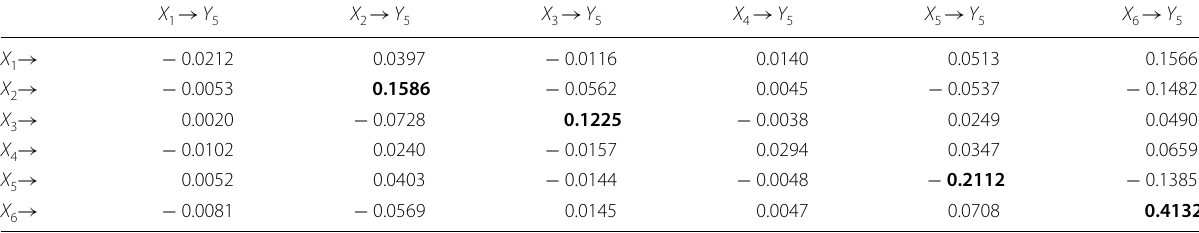
X 1 log height, X 2 = Major direct path coefficients are highlighted in